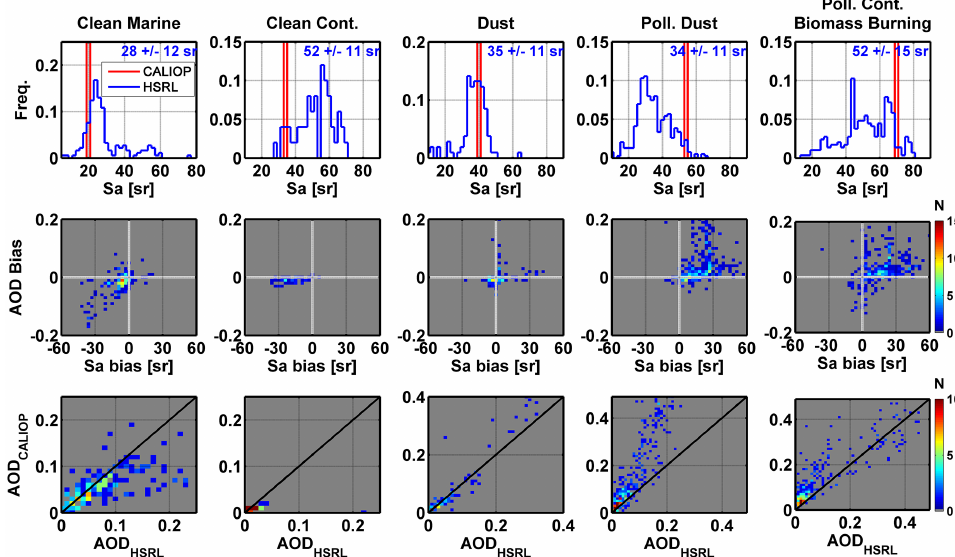
Figure 12. Nighttime histograms of lidar ratio (top row) AOD bias (CALIOP – HSRL) vs. Sa bias (CALIOP – HSRL) (middle row), and AOD scatterplots (bottom row) for each CALIOP aerosol type (columns). The numbers in the top row are the means and SDs of the lidar ratios measured by the